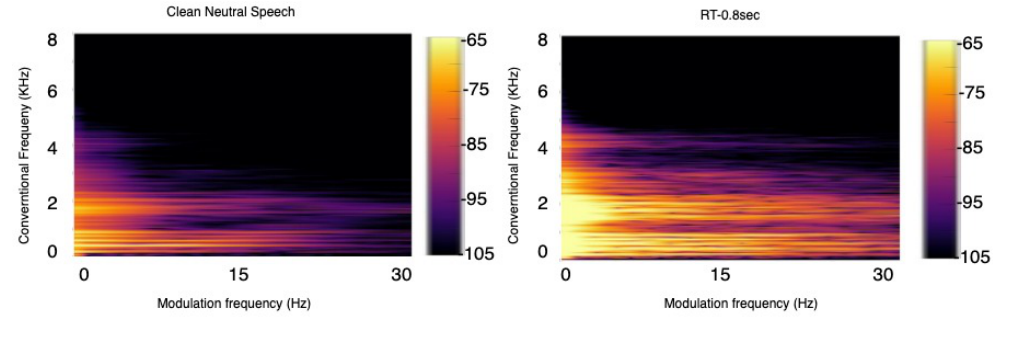
Figure 4. Modulation spectrogram for speech in clean ( left ) and with reverberant (( right ) RT60 = 0.8 s)